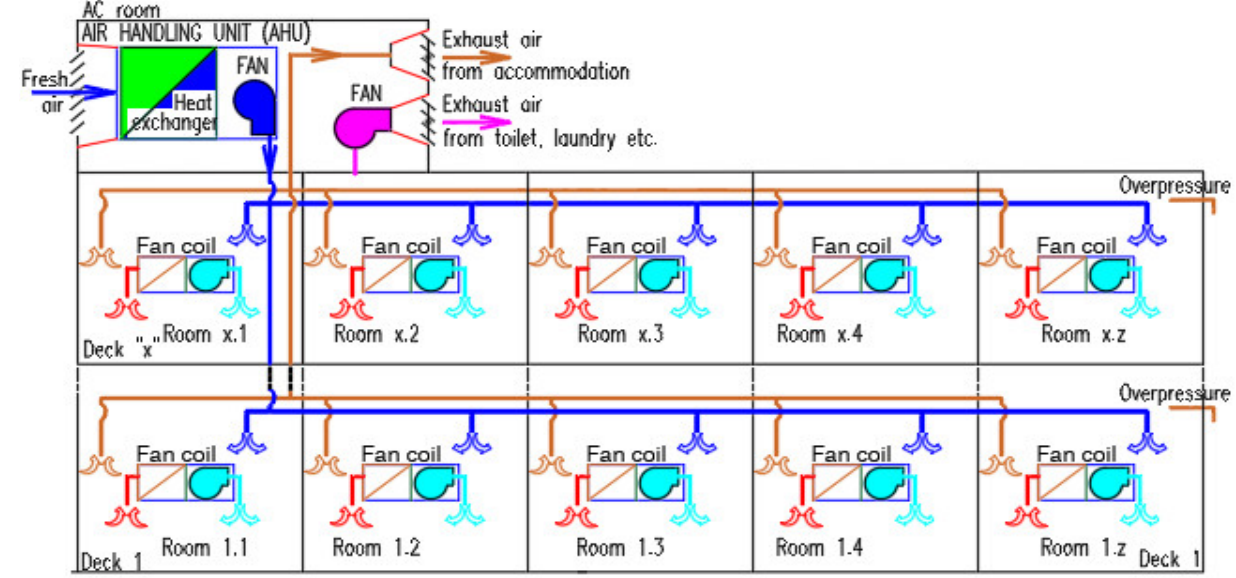
Figure 15. Typical arrangement. Ventilation and air conditioning system improved from a small ship as a proposal for large ships. The system without mixing and air recirculation between rooms, without HEPA filters.